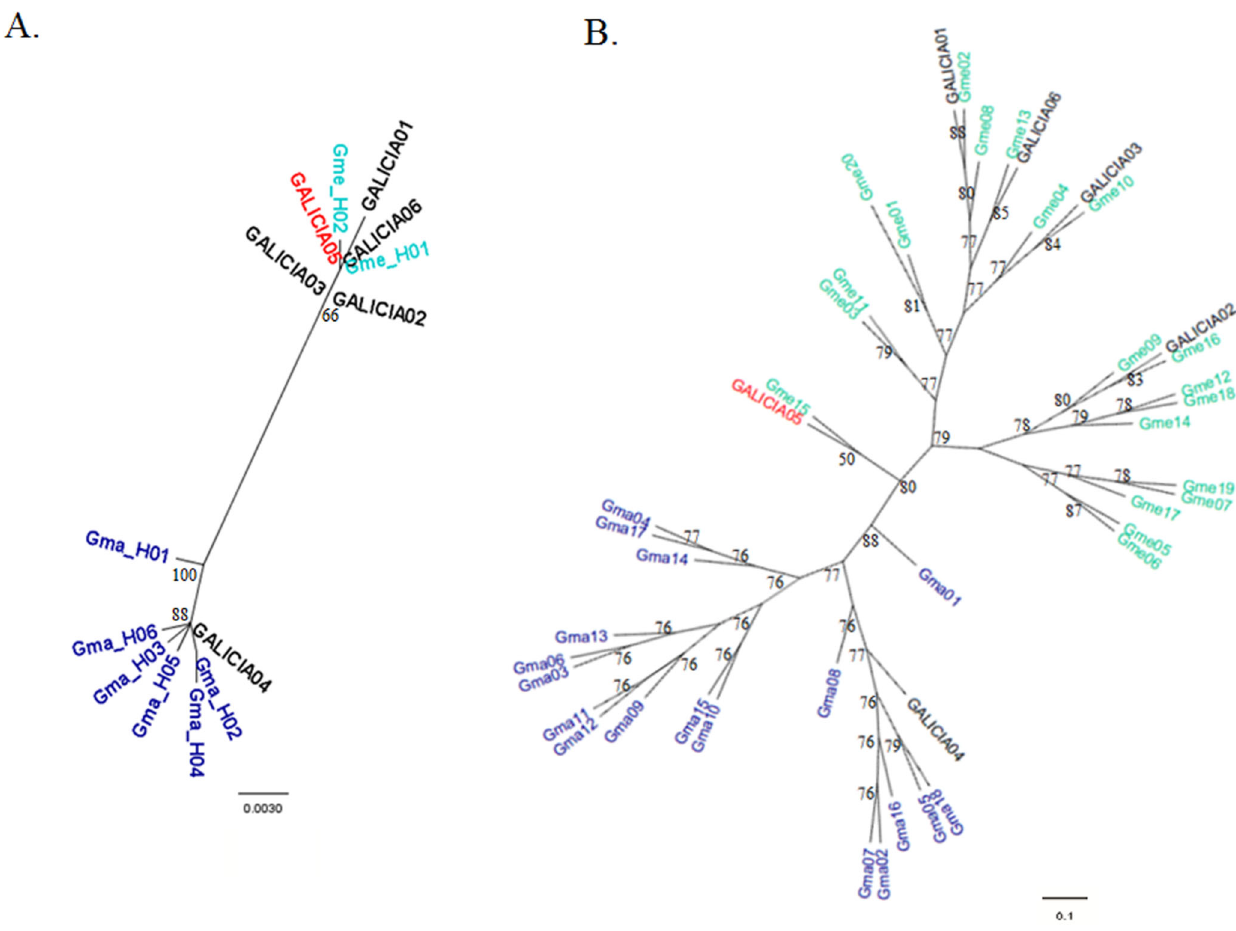
Figure 3. Mitochondrial and nuclear phylogenetic trees of the analyzed samples. Neighbour Joining trees reconstructed based on: A) mitochondrial D-Loop haplotypes; B) microsatellite loci genotypes. G. macrorhynchus is represented in dark blue and G. melas in light blue. Galician strandings are in black except the Post-F1 hybrid (Galicia05) that is in red. Bootstrapping is given for each node. Figure S1 EV37MN microsatellite chromatograms. First graph Globicephala melas , second Globicephala macrorhynchus , and third sample Galicia 05. Figure S2 199/200 microsatellite chromatograms. Graph order as in Figure S1. (TIF)